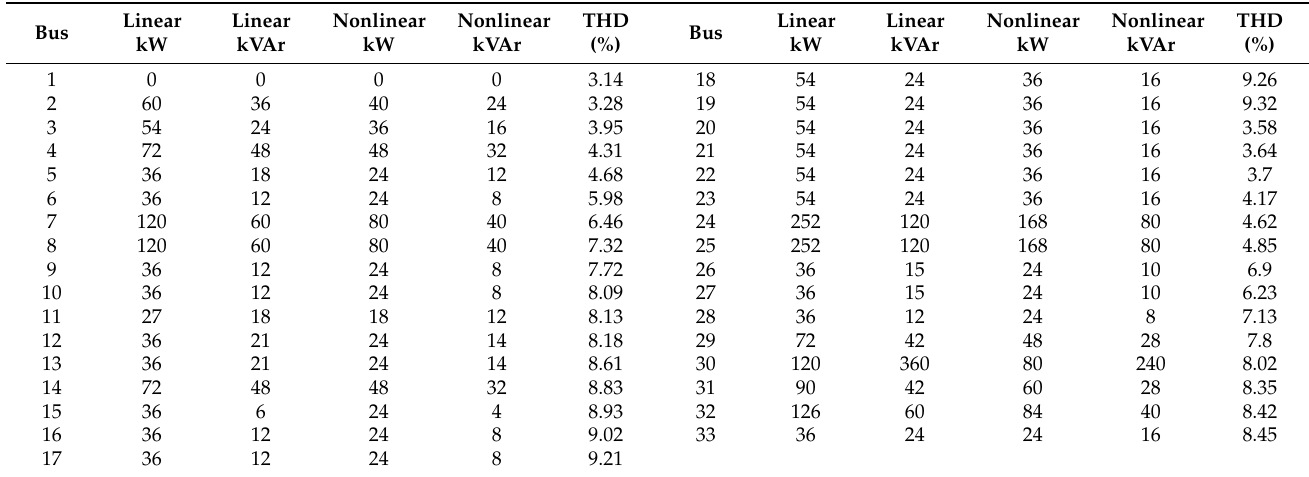
Figure 17. Single line diagram of 33-bus IEEE test network [37].